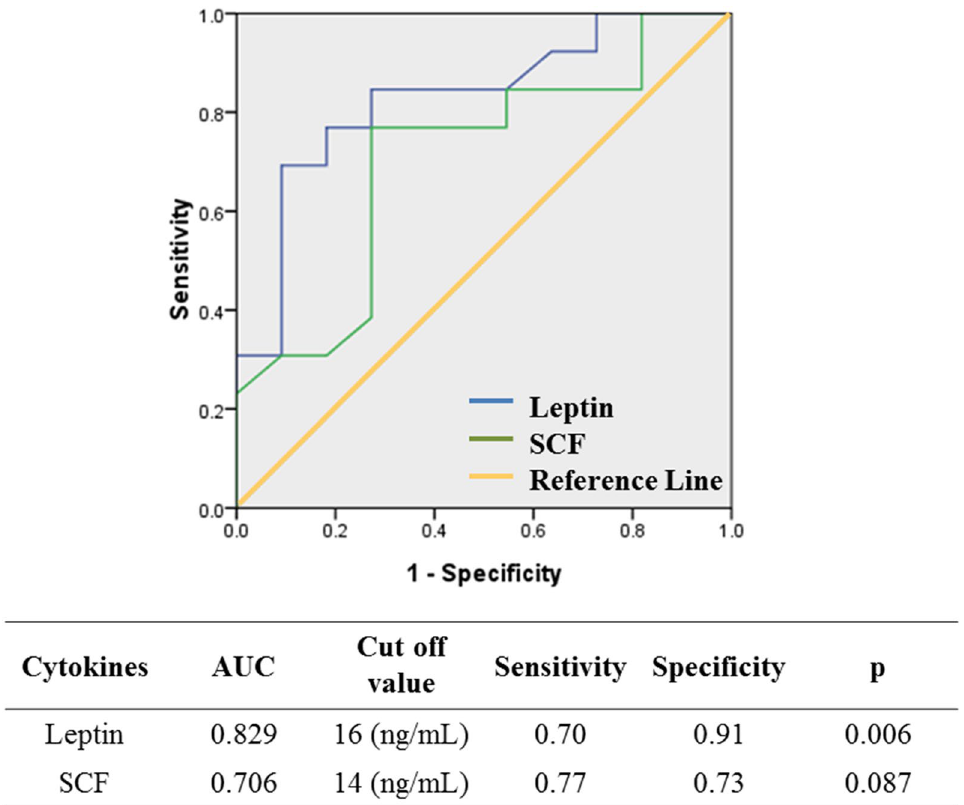
Figure 4. Receiver operating characteristics (ROC) analysis for predicting oocyte maturity according to follicular-fluid cytokine concentrations. The area under the ROC (SPSS output) was 0.829 for leptin [optimal cut-off value, 16 ng/mL; 95% confidence interval (CI), 0.658–0.998; p < 0.01) and 0.706 for SCF (optimal cut-off value, 14 ng/mL; 95% CI, 0.491–0.921; p = 0.087]. Leptin had positive predictive value (sensitivity) up to 70% and negative predictive value (specificity) of 91% for indicating oocyte maturity at its optimal cut-off value. An oocyte maturation rate ≥ 80% was defined as AUC =